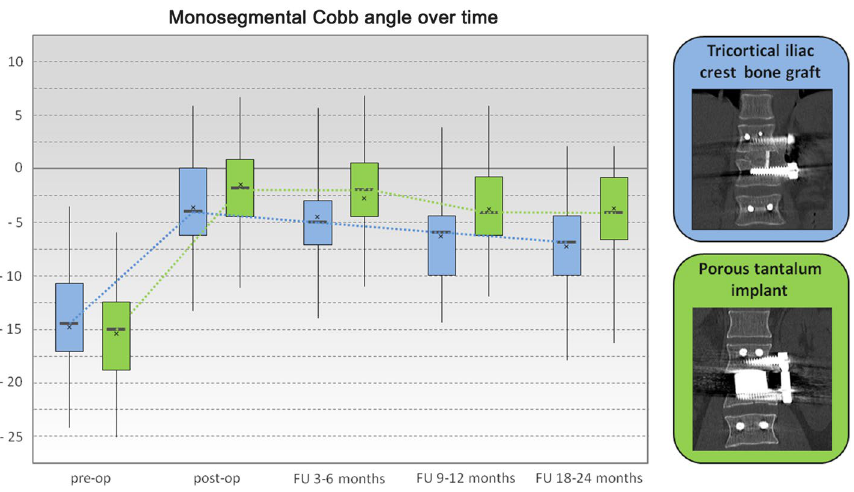
Figure 6. Box and whisker plot showing the changes in the monosegmental Cobb angle. For each box, the lower border is the 25th percentile, and the top border is the 75th percentile. The dark line in the middle of the box is the 50th percentile (the median), and whiskers denote the 2.5th and 97.5th percentiles. The cross indicates the mean value.